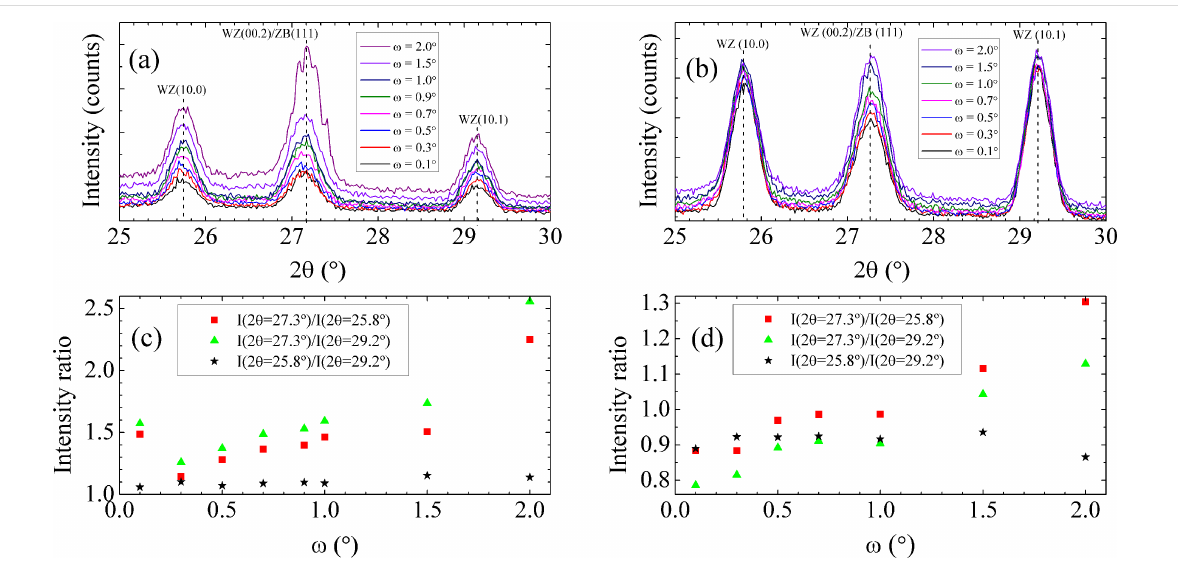
Figure 3: (a), (b) Grazing incidence X-ray diffraction diffractograms ( ω /2 θ ) measured for samples A and B, respectively, obtained with different ω inci- dence angles. (c), (d) Ratios of the relative intensity of the peaks at 2 θ = 25.8, 27.3 and 29.2° as a function of ω for samples A and B, respectively.